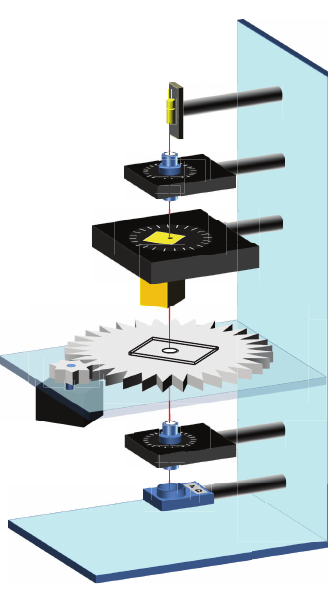
Figure 6: The 3-D structure of the self-made automobile hetero- dyne interferometer.